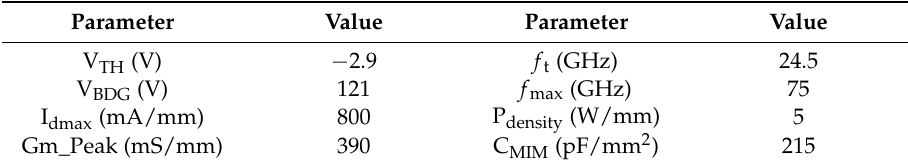
Figure 1. RC model of active devices’ large-signal output impedance. Table 1. The parameters of 0.25 μ m GaN HEMT process.